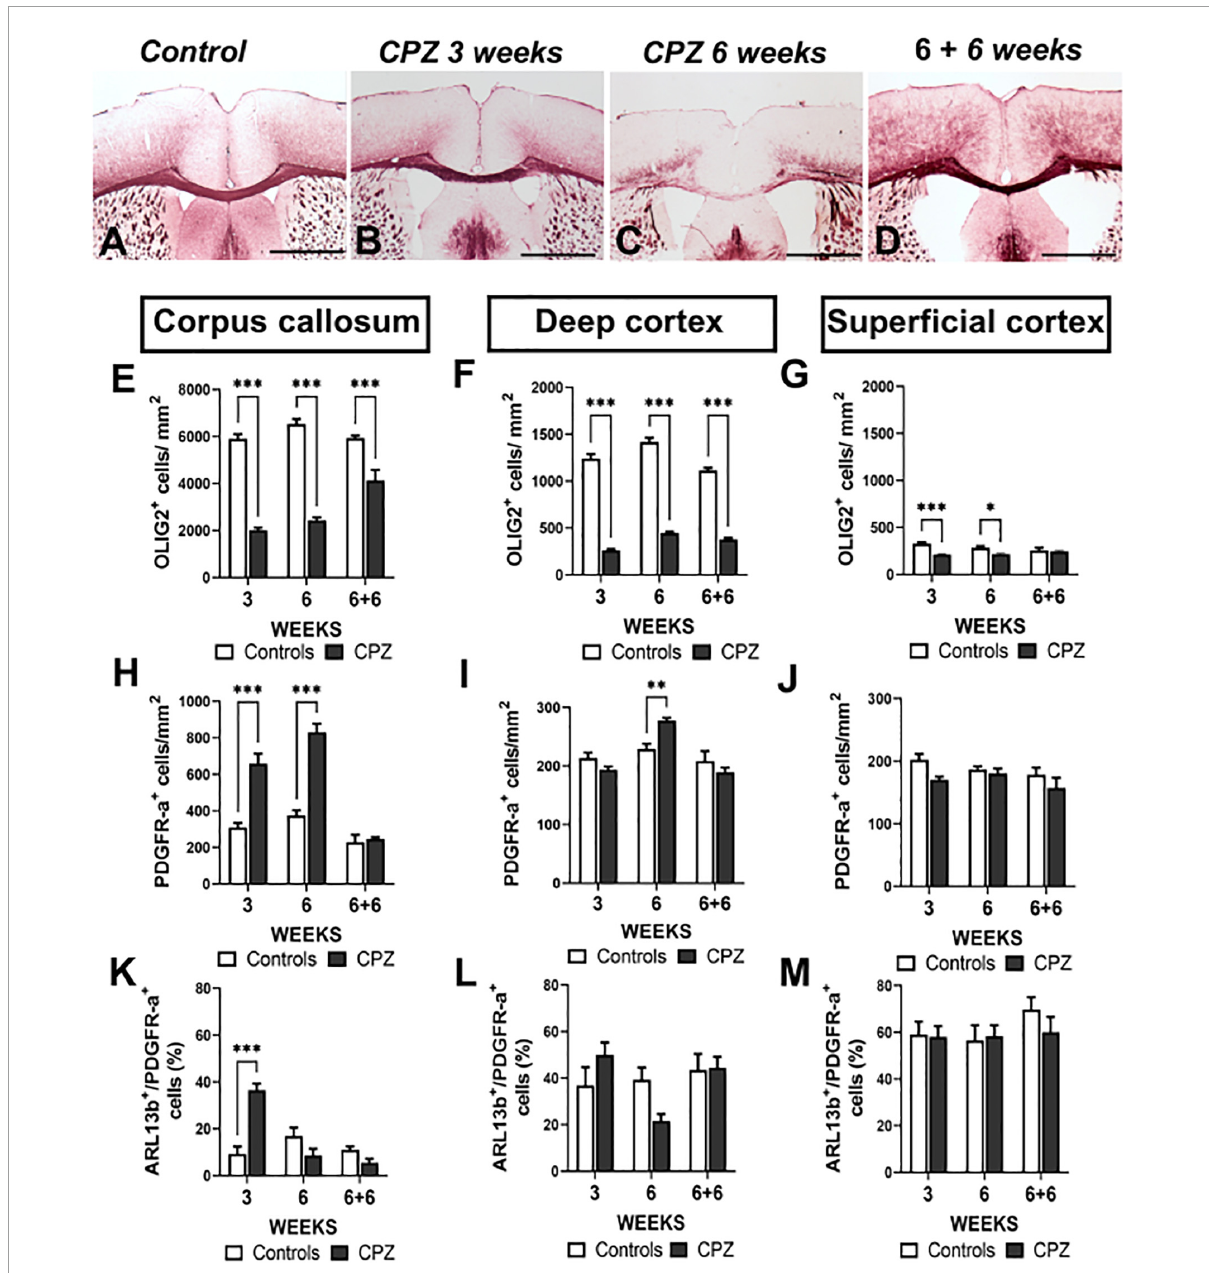
FIGURE4 Ciliated oligodendroglial cells distribution in corpus callosum and cortex during demyelination in cuprizone mouse model. (A–D) Representative images of MBP immunostaining in controls (A) , after 3 (B) and 6 weeks (C) of cuprizone (CPZ) administration and 6 weeks after treatment withdrawal (D) . (E–M) Quantification of OLIG2 + (E–G) , PDGFR-a + (H–J) and ARL13b + cells (K–M) in corpus callosum, superficial cortex and deep cortex during cuprizone induced demyelination. Groups were compered using Two-way ANOVA followed by Bonferroni post-hoc test. Data are presented as mean ± error of the mean (SEM) and asterisks indicate: * p < 0.05, ** p < 0.01, *** p < 0.001. The values for n are available in Supplementary Table 4 . Scale bar is 500 µ m in (A–D) . The inspected cells for the evaluation of ciliated PDGFR-a + percentage was 30–50 cells repeated in three different slices for each animal and each anatomical region